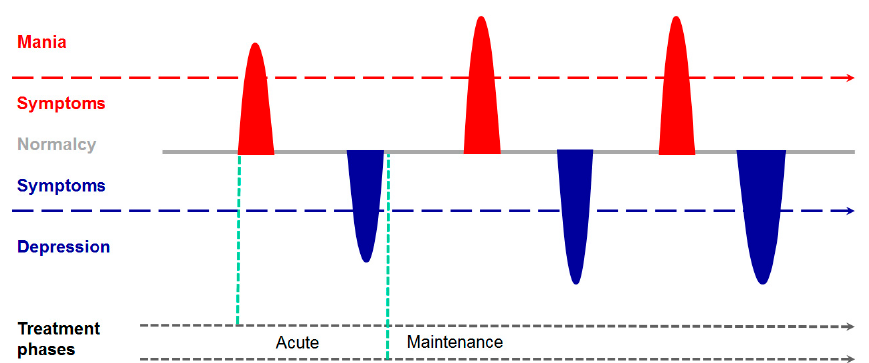
Figure 1. The life cycle of bipolar disease. The more severe form of bipolar disease (BD), called type I, firstly manifests a manic episode (red peak) followed by a depressive episode (blue peak). Following this first cycle, euthymic interphases (grey lines) progressively shorten until a relatively stable pattern of recurrence (single periods and/or entire cycles) develops over time. Concurrently, severity and duration of single episodes tends to increase, particularly for depressive episodes. This scheme illustrates the prototypical course of bipolar disease I whilst varying courses are common. First line treatments for manic episodes are neuroleptics and lithium. The latter can be also used for maintenance therapy of recurrent manic and/or depressive episodes.